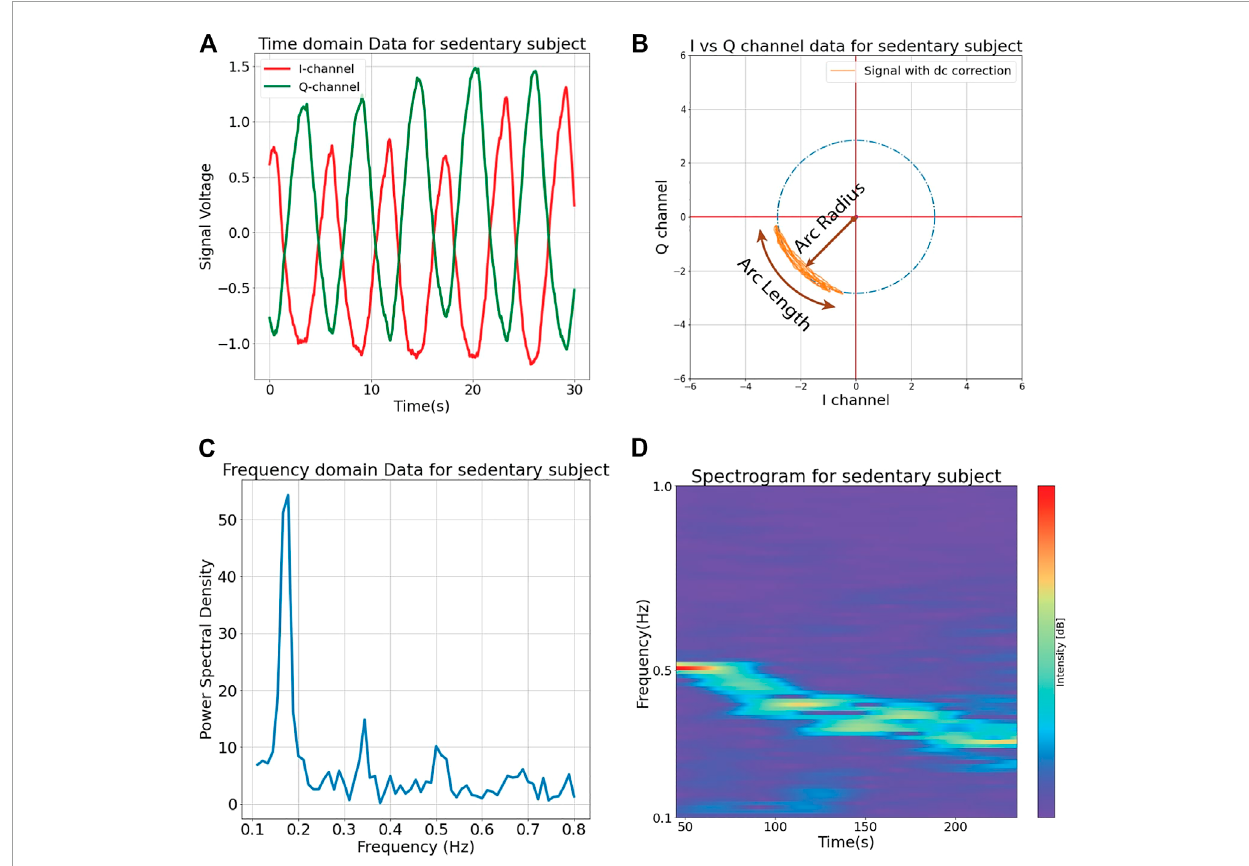
FIGURE 3 Continuous wave 2.4 GHz Doppler radar output signals measured for a sedentary subject. A quadrature receiver is used to produce two signals (I and Q) which are 90° out of phase with each other (A) . I and Q signals can be plotted in a complex constellation to produce an arc that describes signal strength and displacement through the radius and angular changes, respectively (B) . The output can also be analyzed in the frequency domain over some fixed period of time (C) or as a spectrogram illustrating spectral changes over time as in the decreasing respiratory rate illustrated for a subject resting after exertion (D)